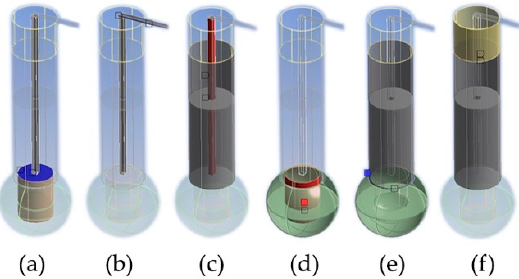
Figure 7. Connected points of the elements considered in the modal analysis by Ansys: ( a ) cylinder beam/ballast; ( b ) cylinder beam/deck; ( c ) cylinder beam/hull cylinder; ( d ) hull sphere/ballast; ( e ) hull cylinder/hull sphere; ( f ) hull cylinder/hull cylinder.